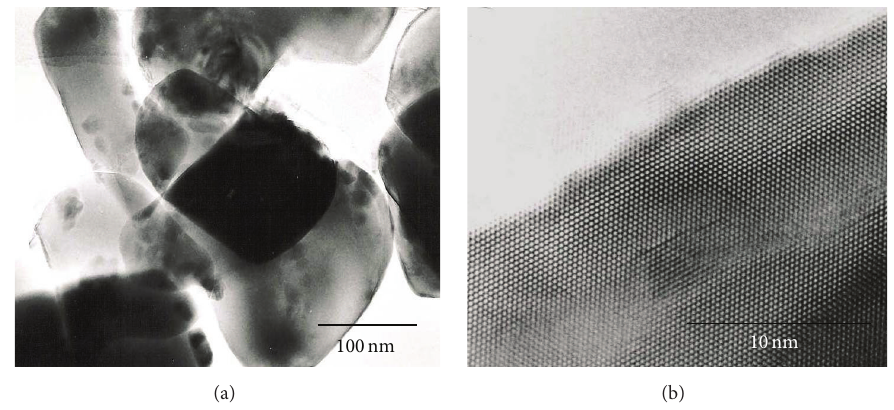
Figure 2: TEM (a) and HRTEM (b) of images of the raw 𝛼 -Al 2 O 3 powders.